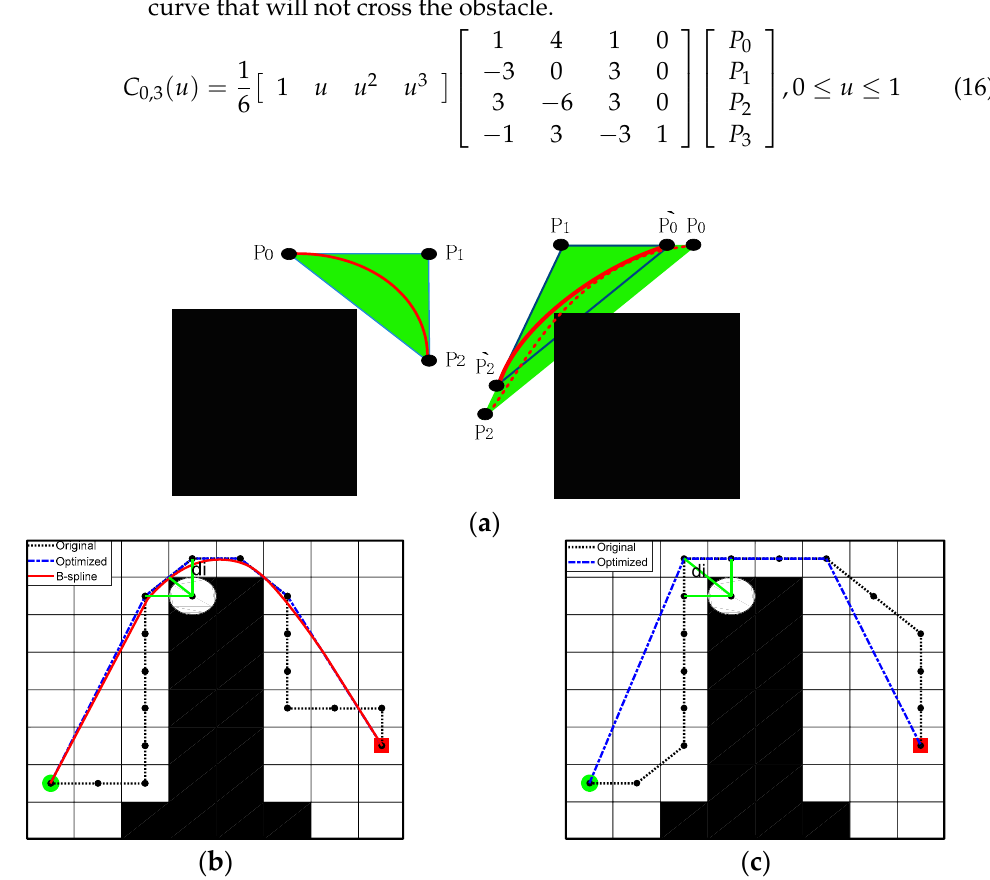
Figure 5. Schematic diagram of path smoothing optimisation; ( a ) Editable node determination; ( b ) The path of mobile robot; and ( c ) The path of mobile obstacle.